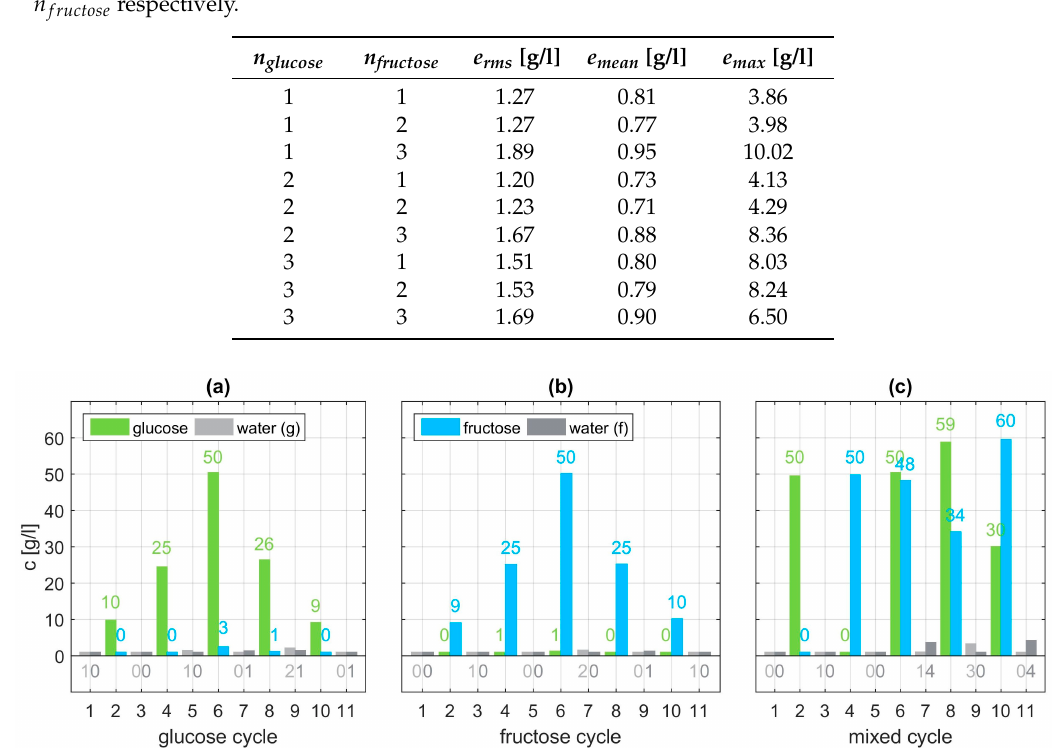
Figure 8. Estimated levels of concentration for the glucose cycle ( a ), fructose cycle ( b ), and mixed cycle ( c ) using cycle-specific constants k i , quadratic polynomials ϕ i and linear basis functions ψ i .